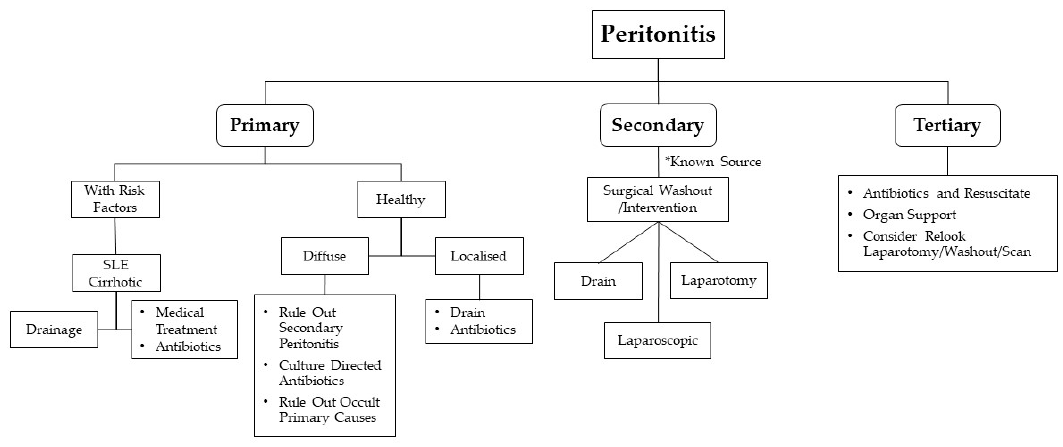
Figure 3. General approach to peritonitis.